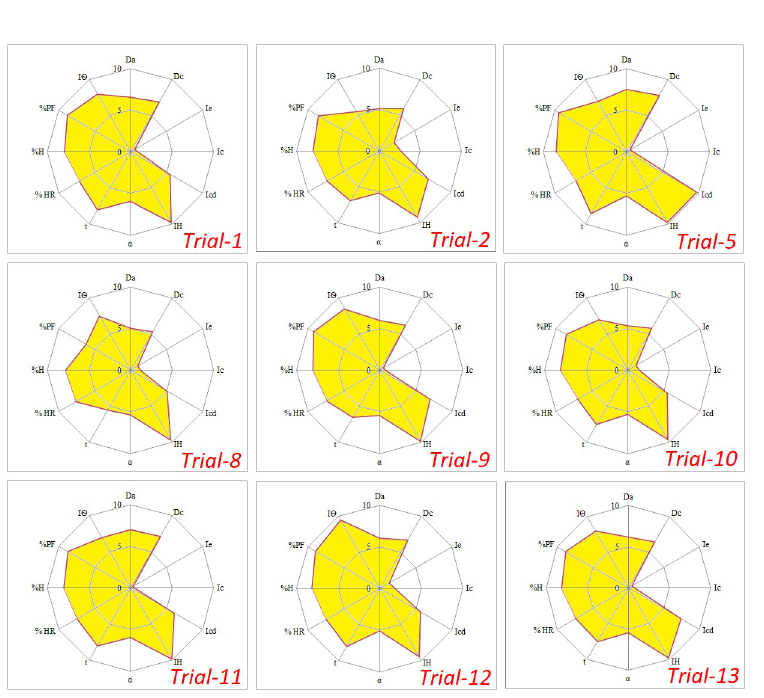
Fig 4. SeDeM diagrams of granules prepared under different levels of process variables. SeDeM expert system predicts suitability of material for compression only.